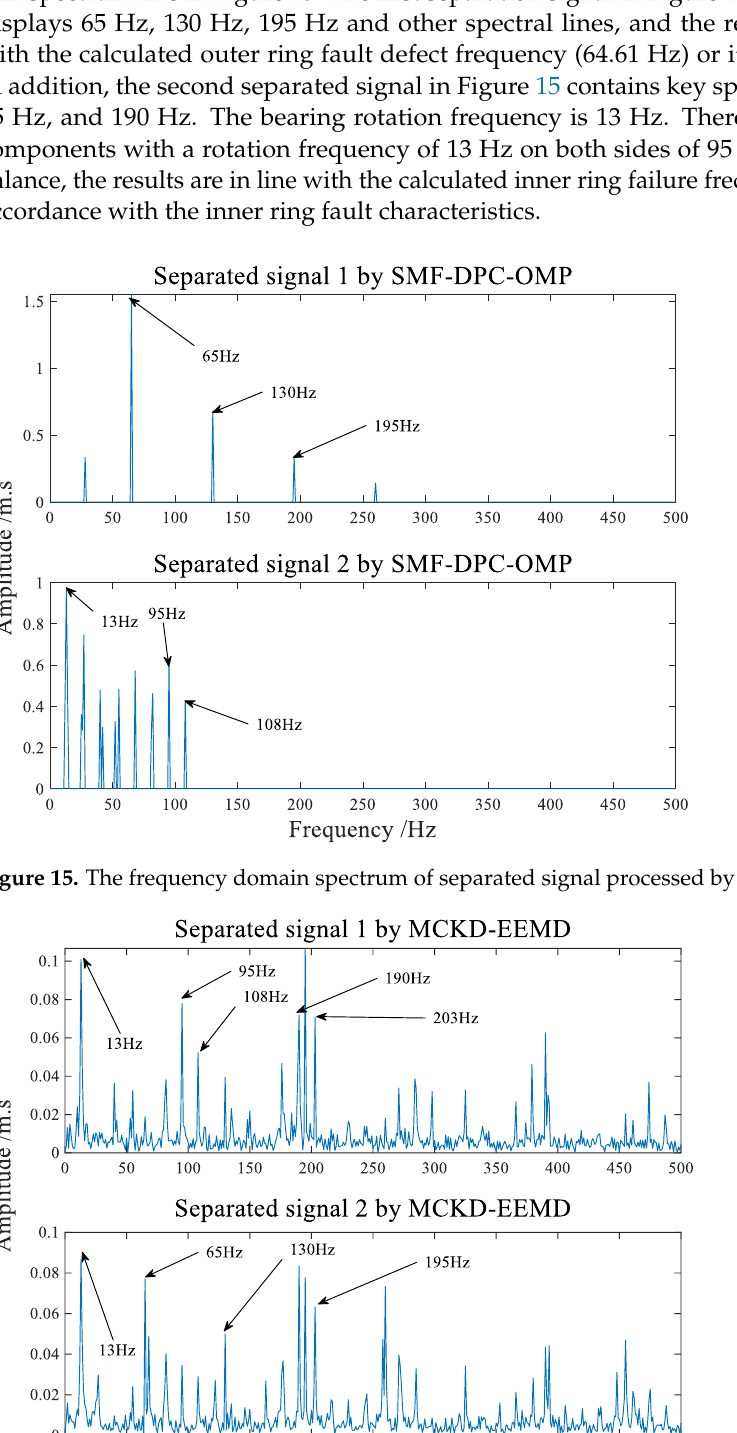
Figure 14. Signal contrast diagram before and after filtering.